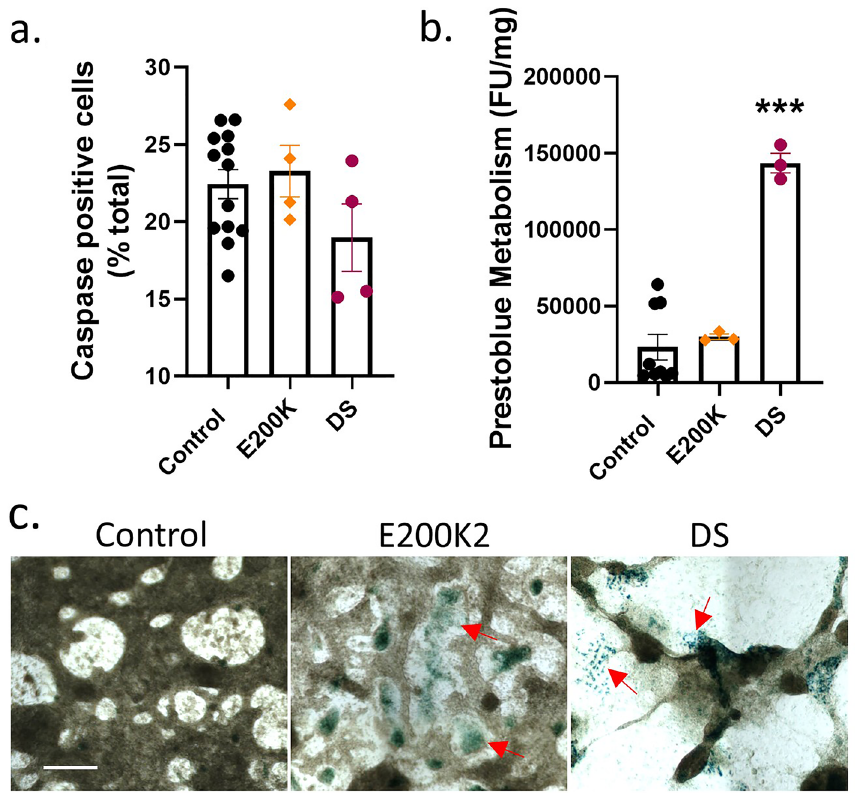
Figure 2. E200K cardiomyocytes show minimal changes in health. Graphs of ( a ) caspase activation and ( b ) prestoblue metabolism assay. ( c ) Example images of β-galactosidase staining (blue; red arrows indicate deposits), an indicator of cellular senescence. Scale bar = 100 µm. Graphs show data points of each independent biological repeat ‘ n ’ with mean and SEM, *p < 0.05 and ***p <